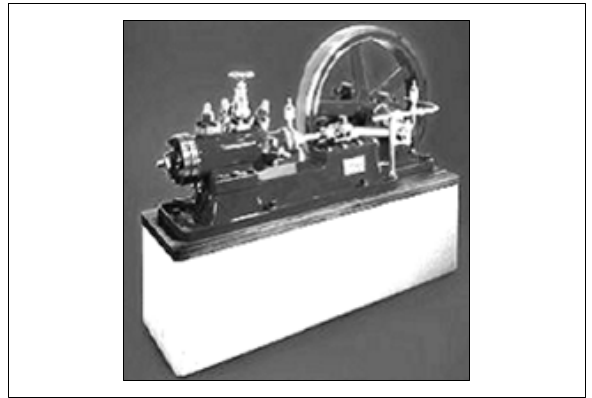
Figure 1: An old single cylinder R744 compressor.